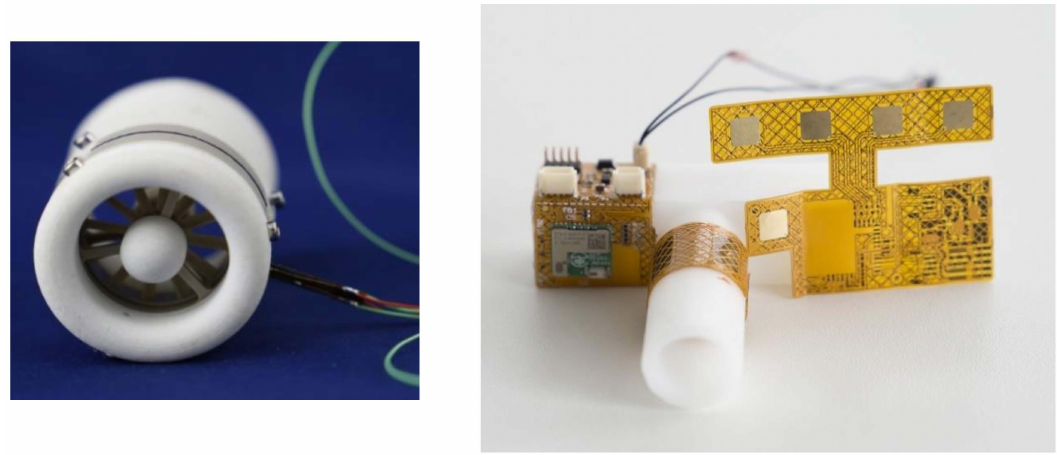
Figure 36. Proposal of electronic and wind harvester